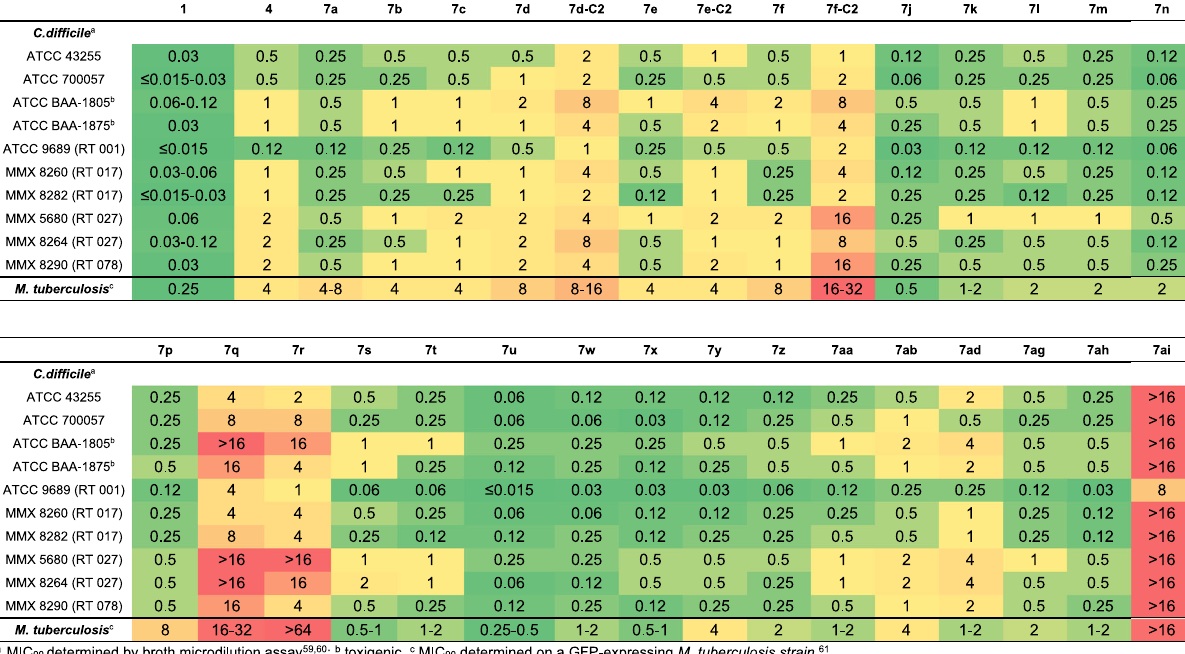
Fig. 8 Minimum inhibitory concentrations (MIC) values. Determination of the MIC in µ g/mL against a panel of different C. dif fi cile strains and M. tuberculosis . RT